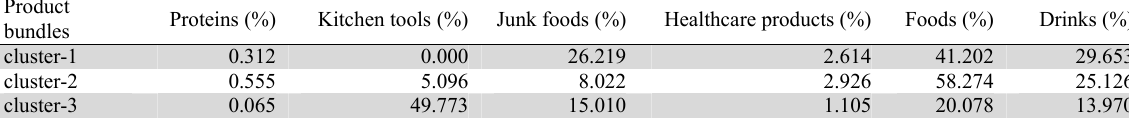
Percentages of product categories in each product bundle for scenario 8 in situation